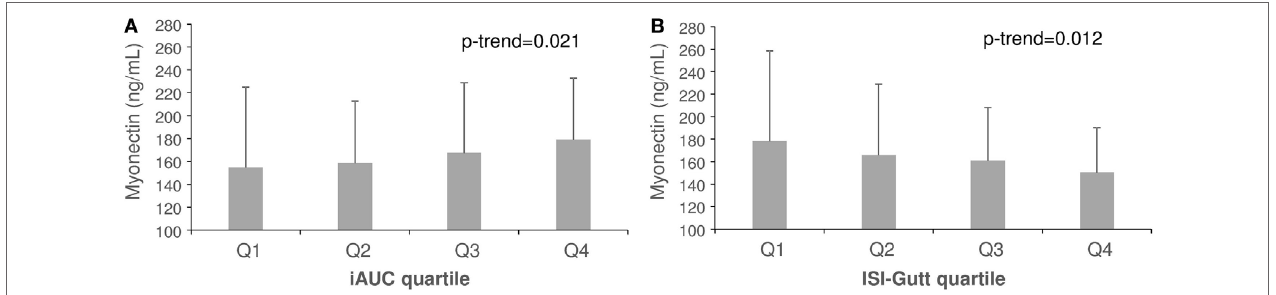
FigUre 1 | Mean concentrations of myonectin across quartiles of incremental area under the insulin curve (a) and insulin sensitivity index (B) . Error bars represent SDs.